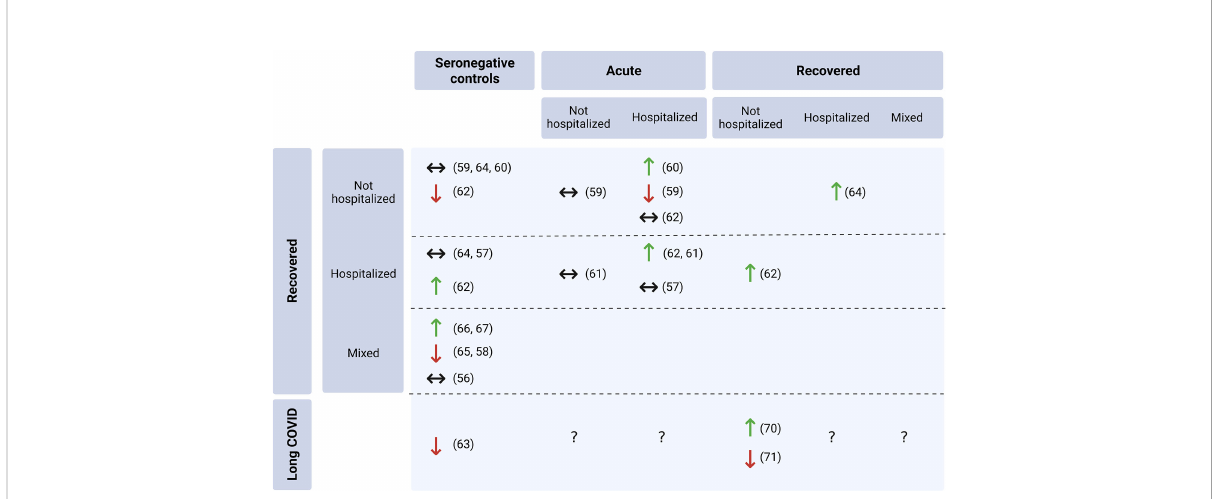
FIGURE 3 Total Treg frequency in convalescent COVID-19 patients compared to other cohorts (references in brackets). The upwards arrow ( ↑ ) indicates a signi fi cant increase at p<0.05, the downwards arrow ( ↓ ) a signi fi cant decrease at p<0.05 and the left-right arrow ( ↔ ) not signi fi cantly different relative Treg proportions in convalescent patients (created with